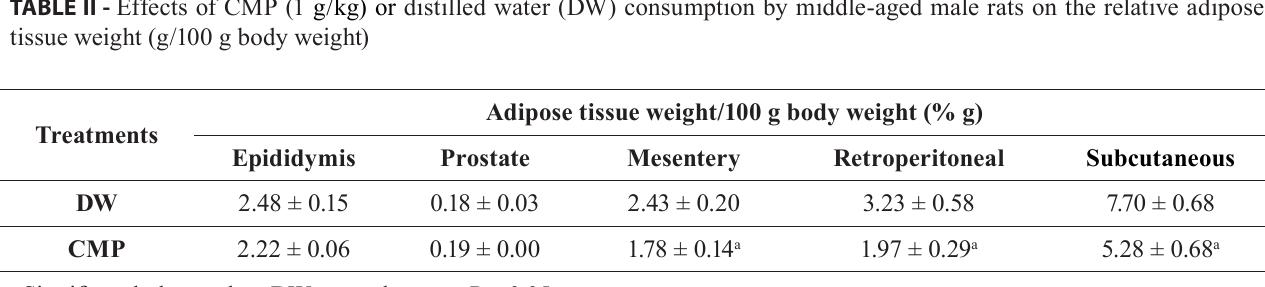
tissue weight (g/100 g body